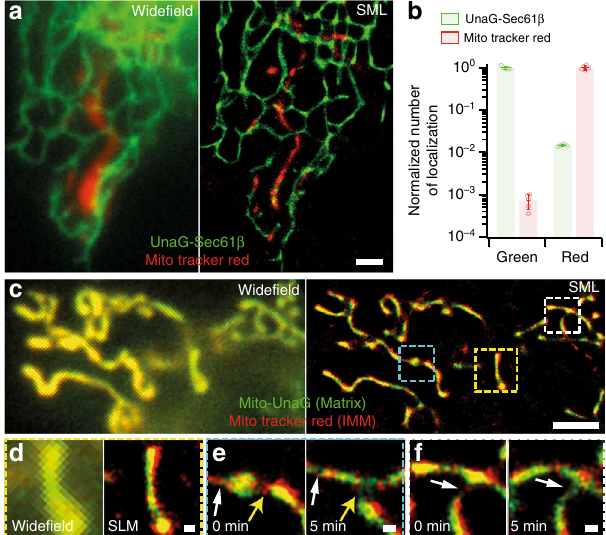
Fig. 6 Two-color live-cell super-resolution microscopy. a ER (green) and mitochondria (red) of a live Cos7 cell in two-color wide fi eld (left) and SML (right) images. The cell was transfected with UnaG-Sec61 β and subsequently stained with MitoTracker Red. The wide fi eld image was taken immediately before super-resolution imaging. b Crosstalk analysis using singly labeled control samples imaged in the two emission channels of green and red split by a dichroic mirror and fi ltered by a single bandpass fi lter for each channel. The localizations numbers were normalized by the average count from the proper color channel. c – f Mitochondrial matrix (green) and inner membrane (red) in two-color SML images of a live Cos7 cell transfected with Mito-UnaG and stained by MitoTracker Red. c A far view comparison between wide fi eld (left) and SML (right) images. d Close- up comparison between wide fi eld (left) and SML (right) images of yellow- boxed region in c . e , f Zoom-ins in the cyan- and white-boxed regions in c at 0 min (left) and after 5 min (right) with fusion (white arrows) and fi ssion (yellow arrows) events. Scale bars: 2 µ m for a , c ; 200 nm for d , f . Error bars: standard deviations ( n = 5, from independent SML